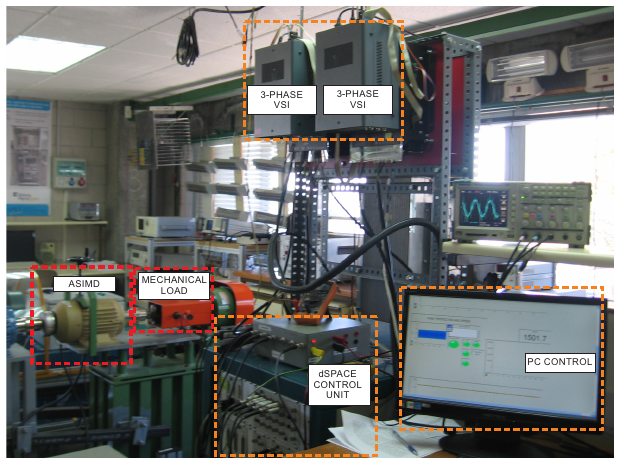
Figure 6. Experimental test